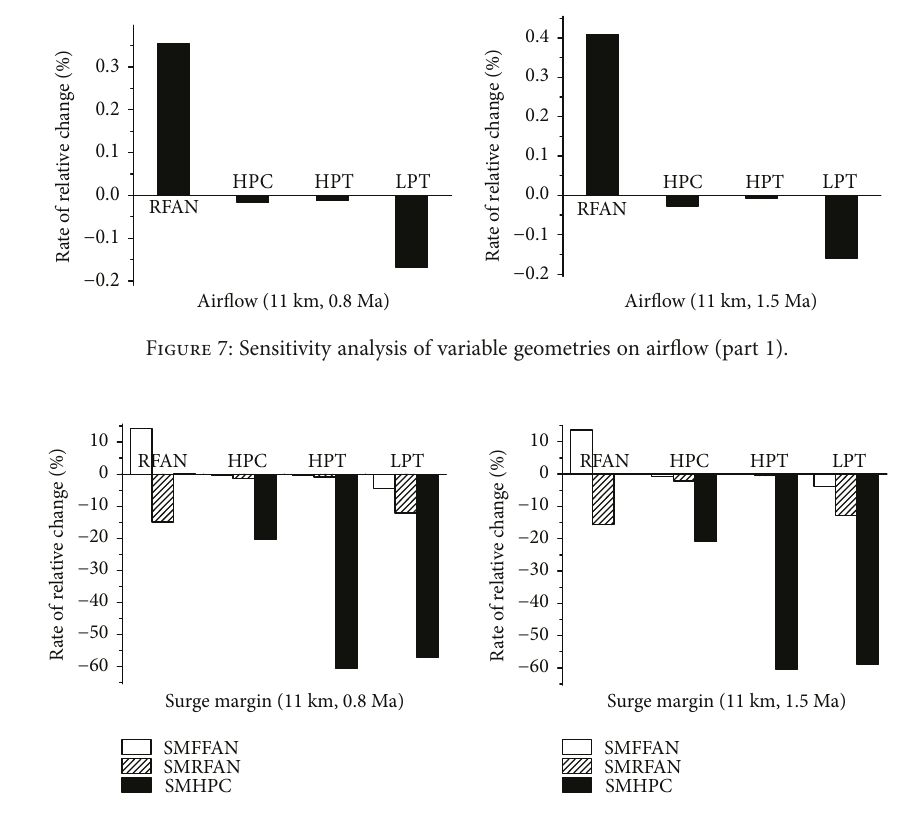
Figure 8: Sensitivity analysis of variable geometries on surge margin (part